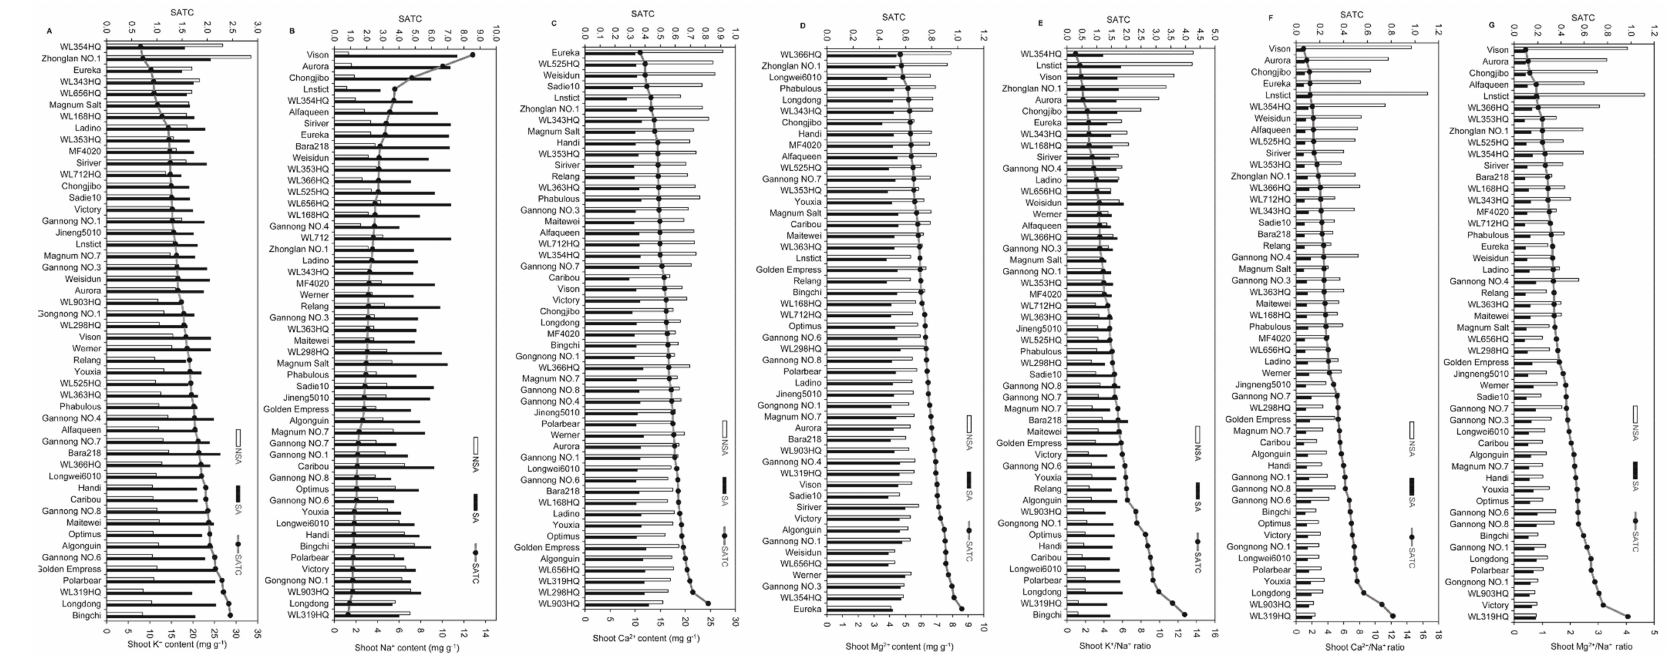
Figure 3. The K + , Na + , Ca 2 + , and Mg 2 + contents (A–D) and the ratios of K + , Ca 2 + , and Mg 2 + to Na + (E–G) in the shoots of 50 alfalfa cultivars field-grown in nonsaline-alkaline (NSA) (open bar) soils and saline-alkaline (SA) (solid bar) soils during the seedling stage. The line represents saline-alkaline-tolerance coe ffi cient (SATC). Values are the means of absolute values, n =